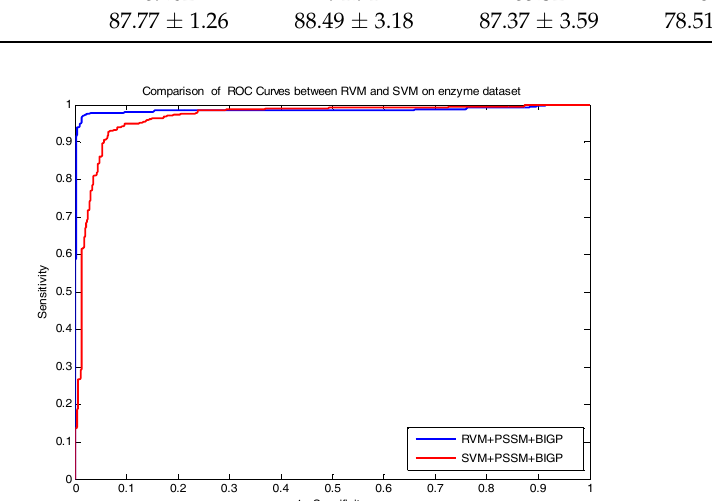
Figure 2. Comparison of ROC curves performed between RVM and SVM on an enzyme dataset. Table 5. 5-fold cross validation results performed by SVM and RVM classifiers on an enzyme dataset. Comparison of ROC Curves between RVM and SVM on ion channel dataset Testing Set